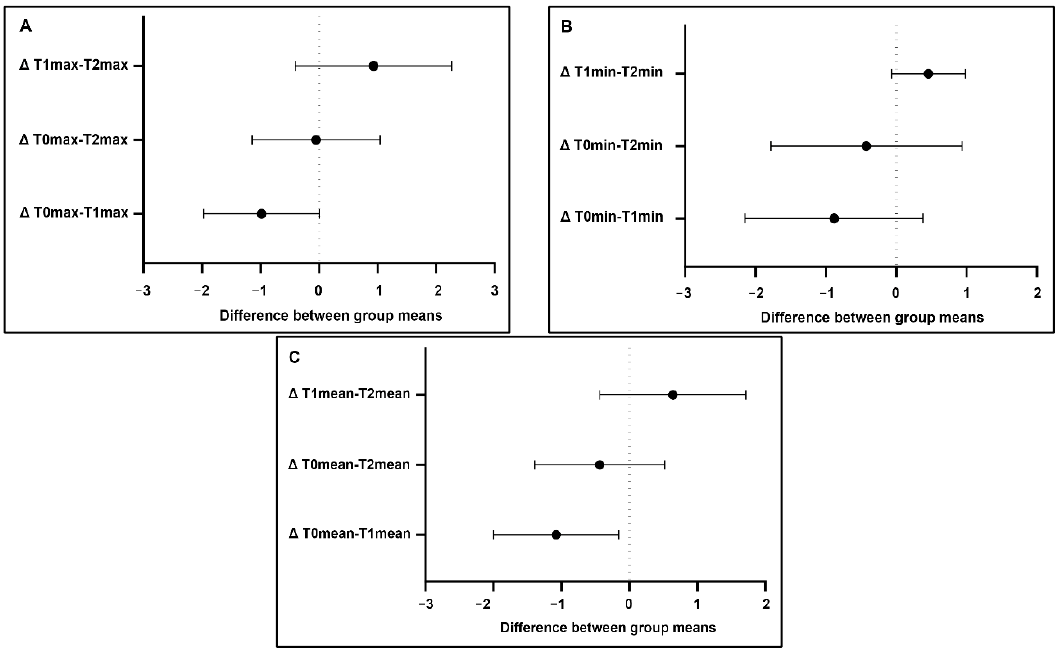
Figure 3. Maximum ( A ), minimum ( B ) and mean ( C ) temperature differences in the lines (diagonal): the intersection with the dotted line identifies “not statistical significance”. Only the mean difference in temperature T0–T1 is significant ( C ). Δ = temperature difference in °C.